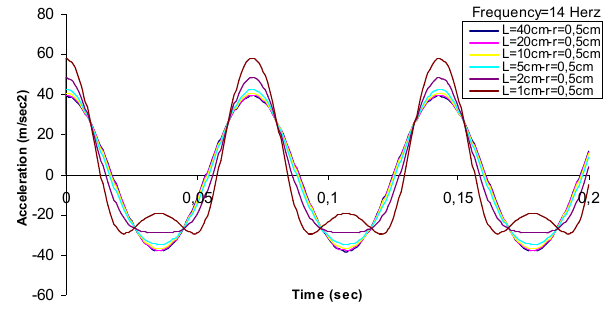
Fig. 7 Acceleration versus time graph of the platform for frequency 14 Hz Fig. 7. Acceleration versus time graph of the platform for frequency